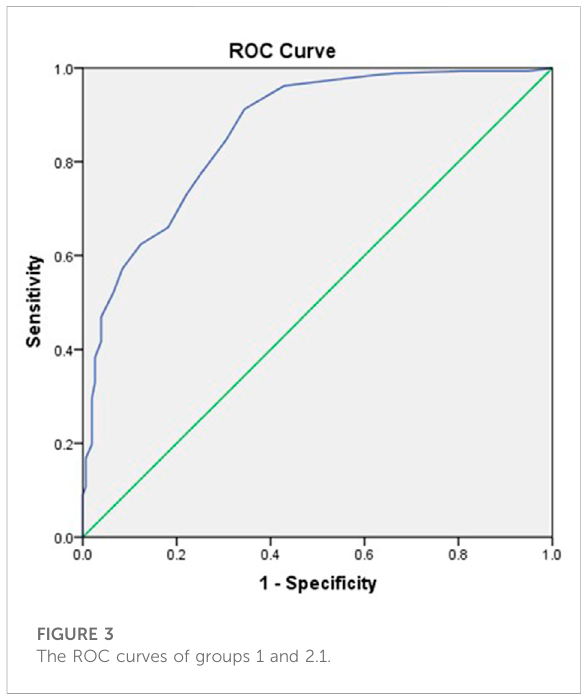
FIGURE 3 The ROC curves of groups 1 and 2.1.